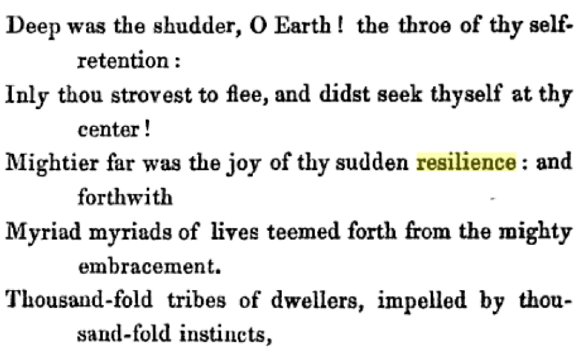
Fig. 4. Resilience in Coleridge’s Hymn to the Earth , 1834.